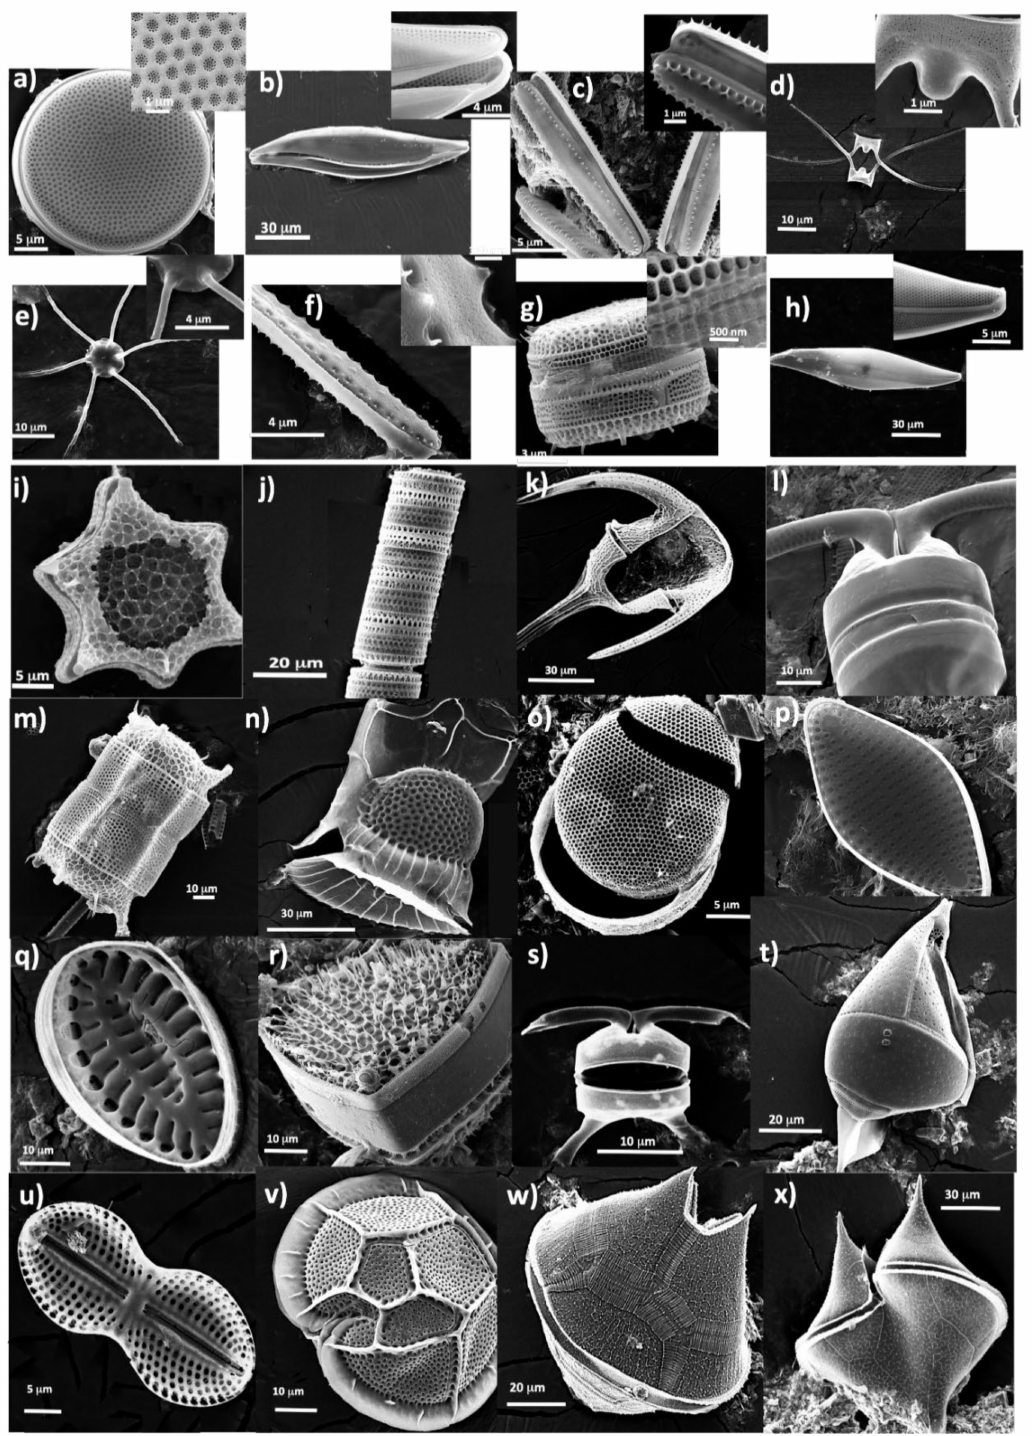
Figure 7. Common algal bloom species in the north Indian Ocean imaged using an electronic micro- scope: ( a , g , o ) Thalassiosira , ( b , h ) Pleurosigma , ( c , f ) Thalassionema , ( d , l , s ) Chaetoceros , ( e ) Bacteriastrum , ( i , r ) Triceratium , ( j ) Aulacoseira , ( k ) Ceratium , ( m ) Odontella , ( n ) Dinophysis , ( p ) Geissleria , ( q ) Surirella , ( t , w , x ) Protoperidinium , ( u ) Diploneis , and ( v ) Pyrodinium . The bar shows the scale of the image in µ